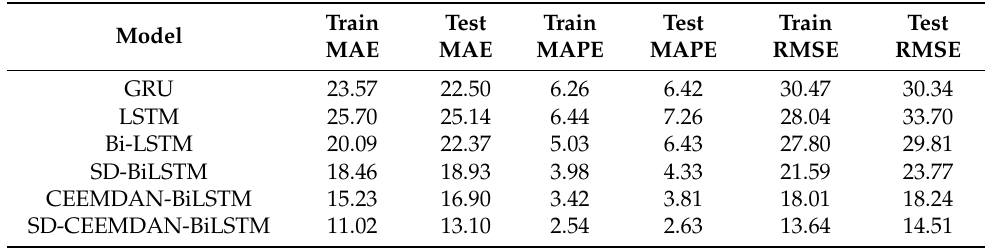
Table 2. Prediction evaluation indicators for six models. MAE: Mean Absolute Error, MAPE: